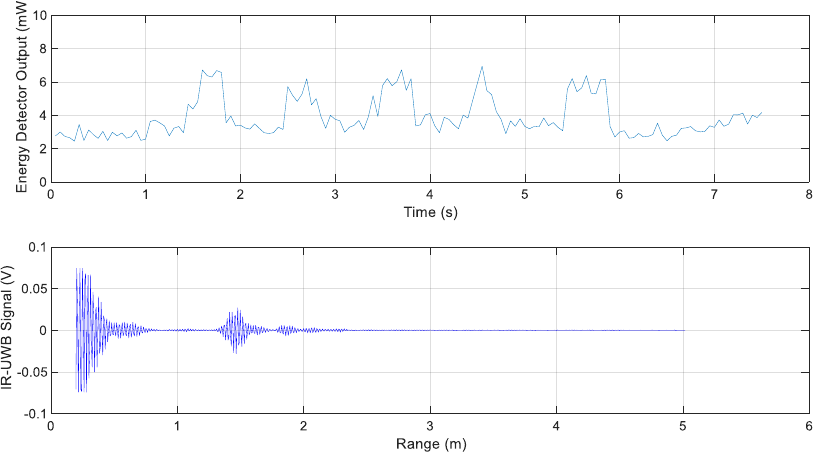
Figure 9. Energy detector output and IR-UWB signal for Scenario 2.